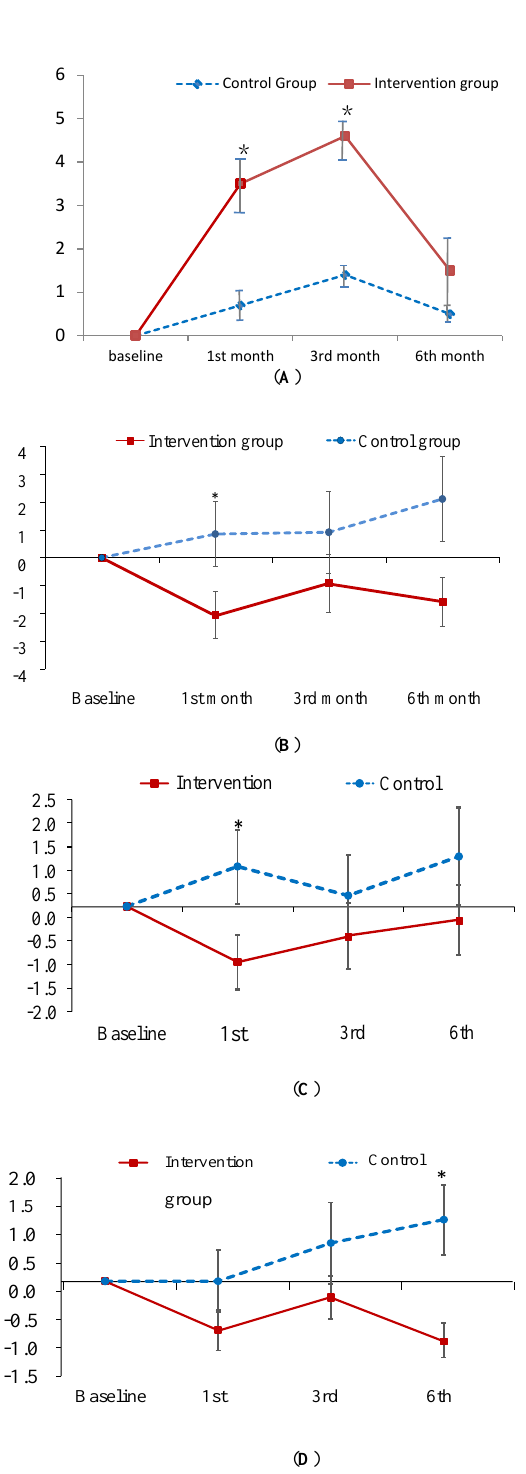
Figure 2. Mean difference from baseline to post-test and its standard error of knowledge on PM ( A ) and CAT score ( B – D ) at each follow-ups in the intervention and control groups. * indicates the difference of the changed values from the baseline to a specific follow-up between the two groups is statistically significant. ( A ) change relative baseline of knowledge on air pollution; ( B ) chage relative baseline of CAT score; ( C ) change relative to baseline of CAT physical score; ( D ) change relative to baseline of CAT psychological score.